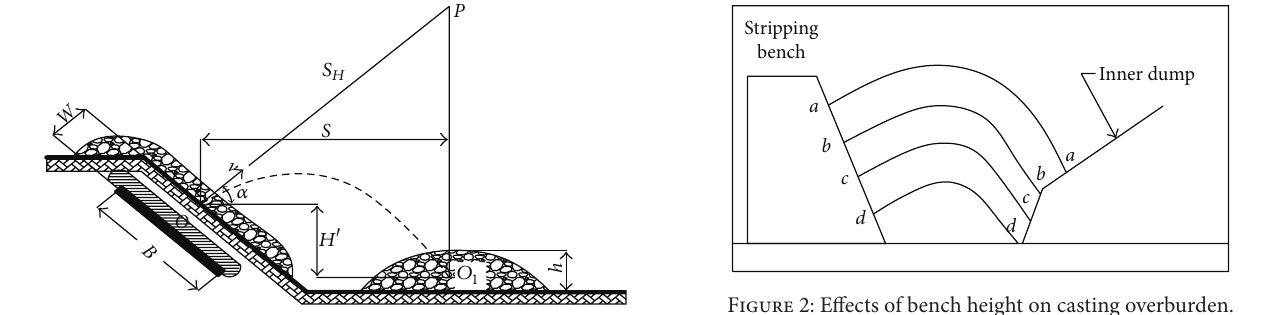
Figure 1: The blast casting model.